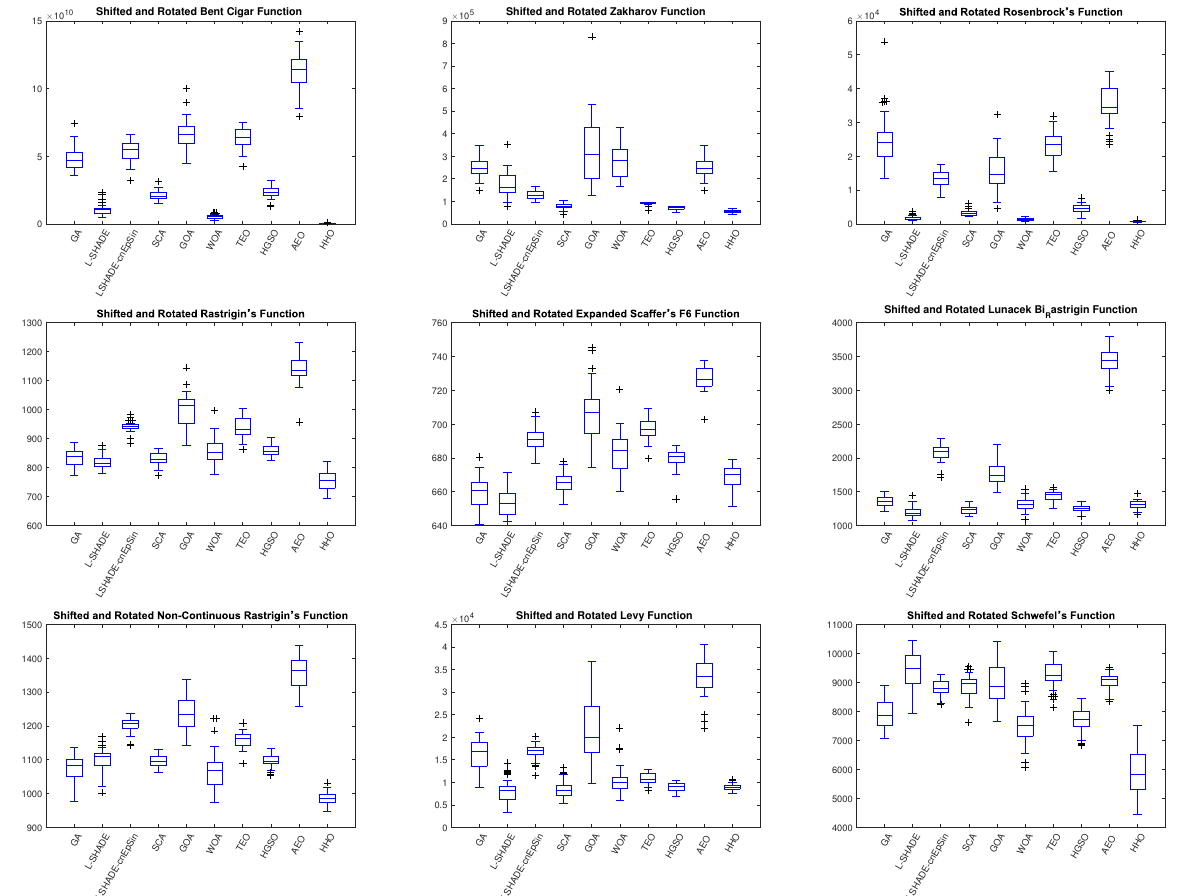
Figure 9. Boxplot of some functions from F1–F10 for all